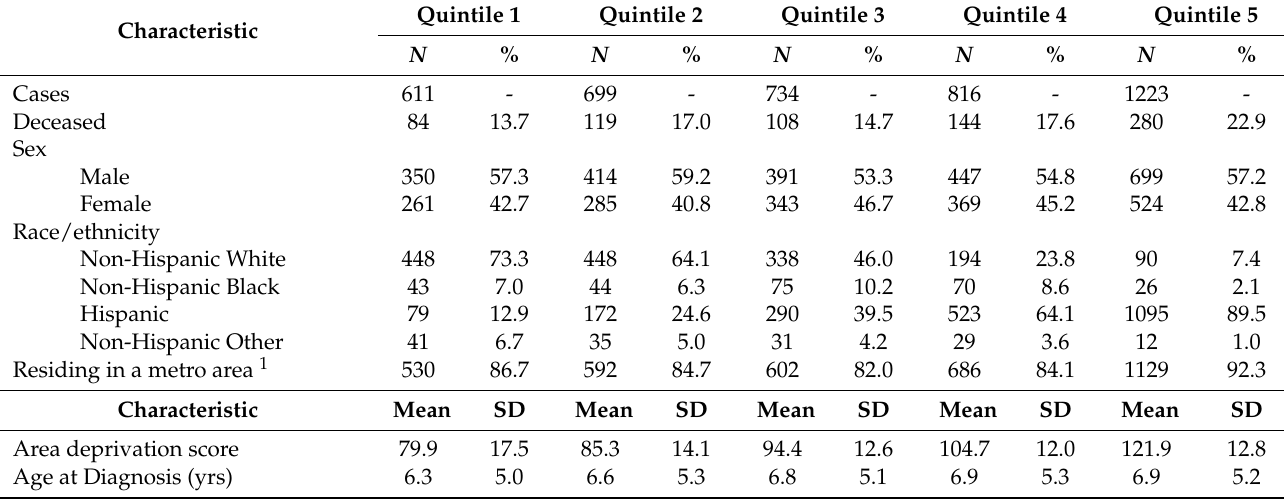
Table 1. Demographic characteristics of children with acute lymphoblastic leukemia (ALL) according to Hispanic enclave scores. Quintile 1 Quintile 2 Characteristic